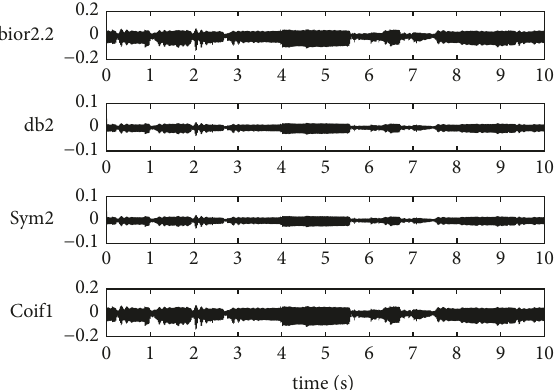
Figure 12: Detail coefficients of the direct method with different